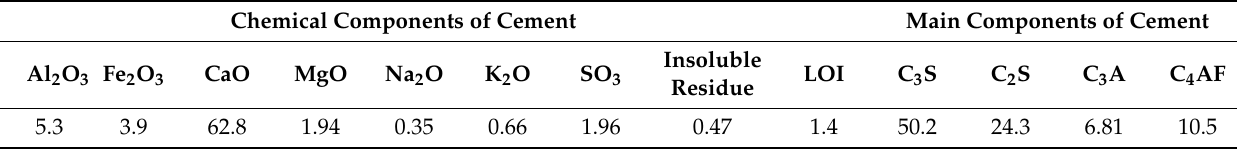
Table 1. Chemical composition and main components of